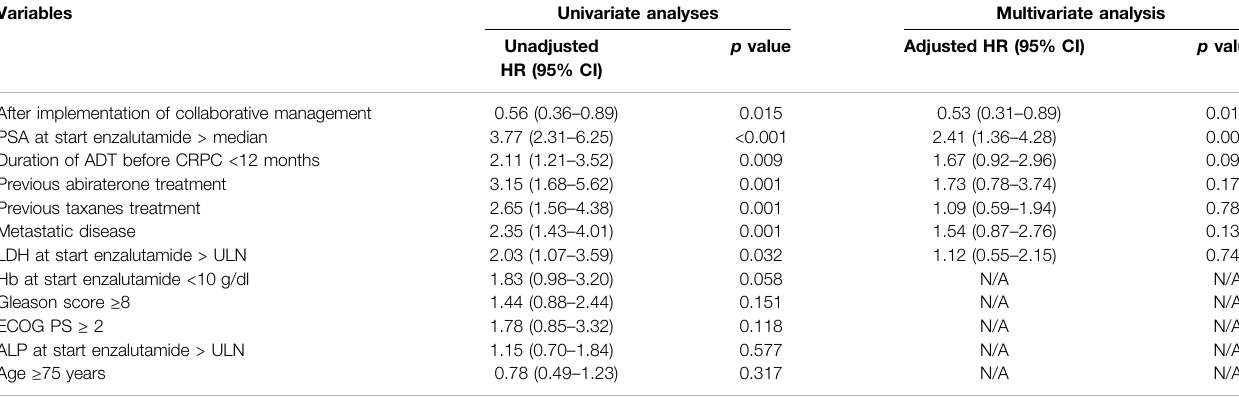
TABLE 2 | Univariate and multivariate Cox proportional hazard models for time to enzalutamide discontinuation. Variables Univariate analyses Multivariate analysis p value Adjusted HR (95% CI) p Unadjusted HR (95% CI)